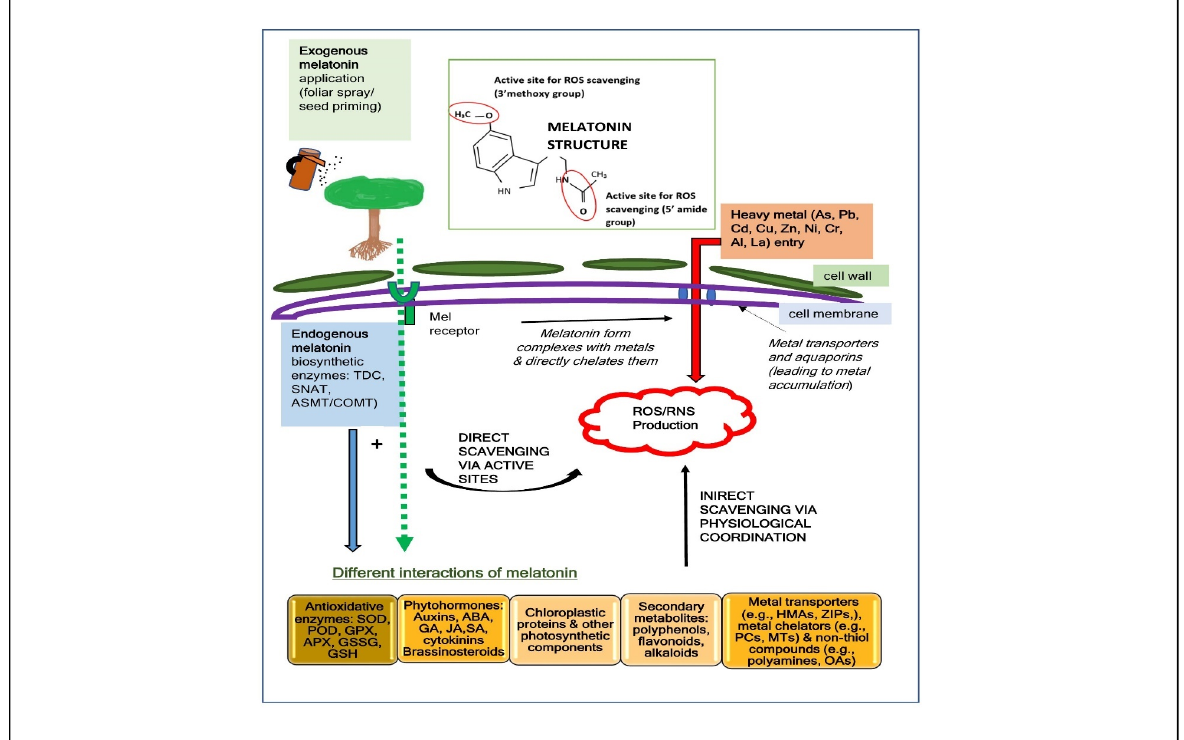
Figure 2: Diagrammatic representation of the melatonin-induced regulations in plant cells under HM